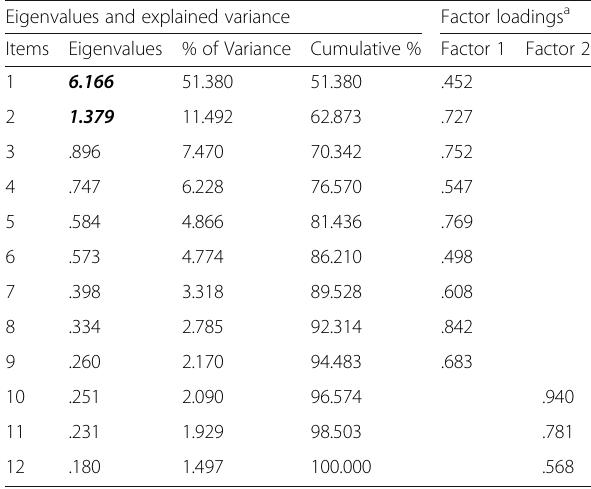
Table 2 Factor analysis of the international Hip Outcome Tool (12 items) - Greek version questionnaire ( n = 124) Eigenvalues and explained variance Factor loadings